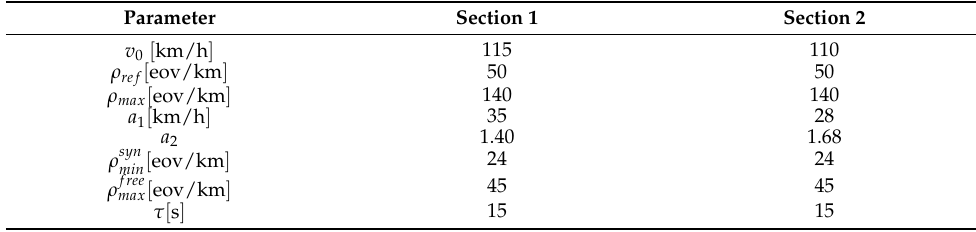
Table 1. Model parameters after calibration.